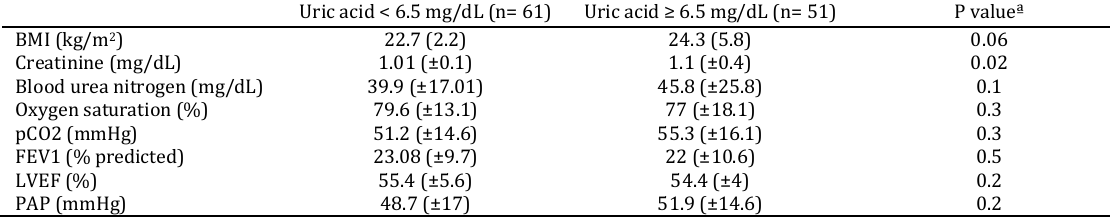
Table 1. Comparison of quantitative variables assessed at the first presentation between the low and high uric acid groups Uric acid < 6.5 mg/dL (n= 61) Uric acid ≥ 6.5 mg/dL (n= 51) P valueª BMI (kg/m 2